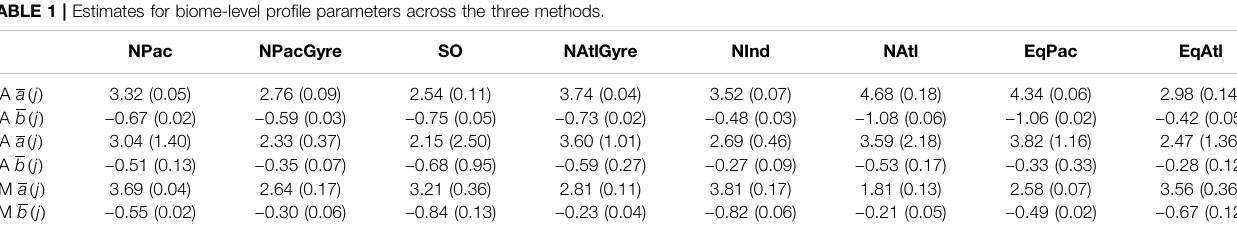
DA indicates data-aggregation, PA parameter-aggregation, and HM indicates hierarchical model. The mean of the posterior distribution is given with the posterior standard deviation in